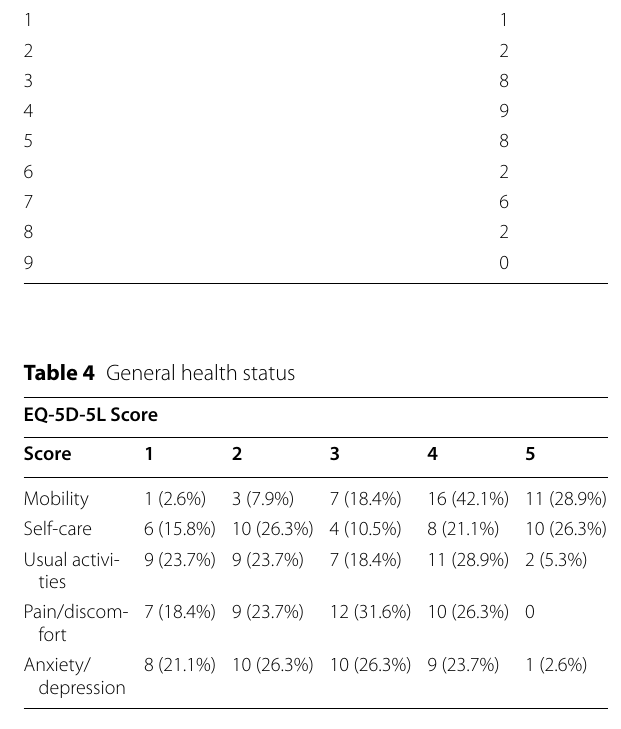
Table 5 Main comorbidities in the study population Comorbidities